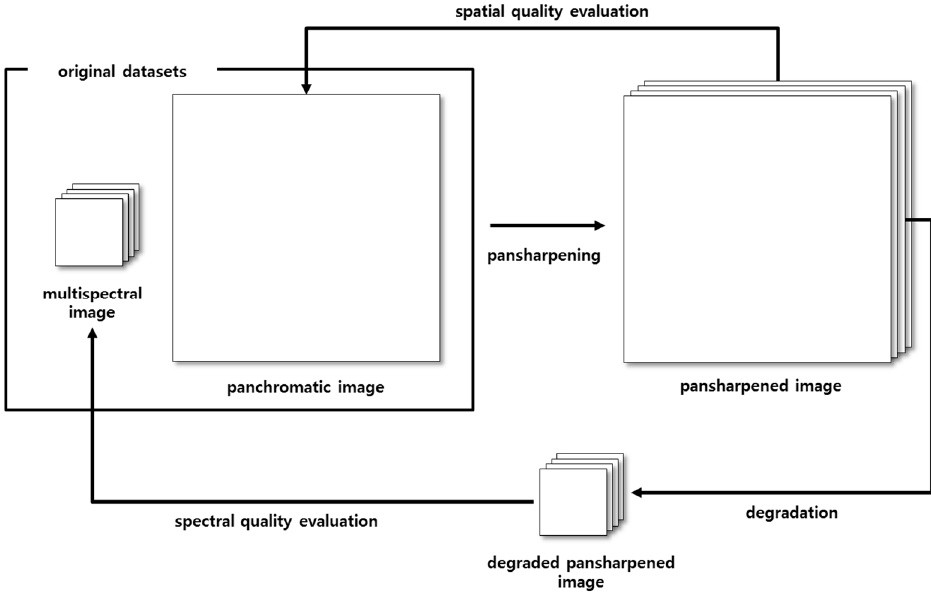
Figure 5. Workflow for evaluating the consistency property in evaluating the quality of pansharpened images.